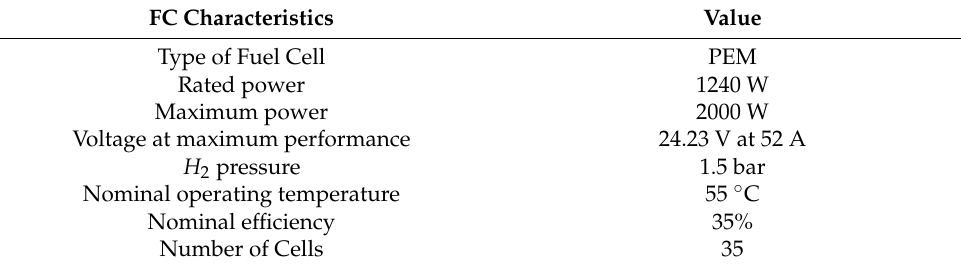
Table 4. Fuel cell